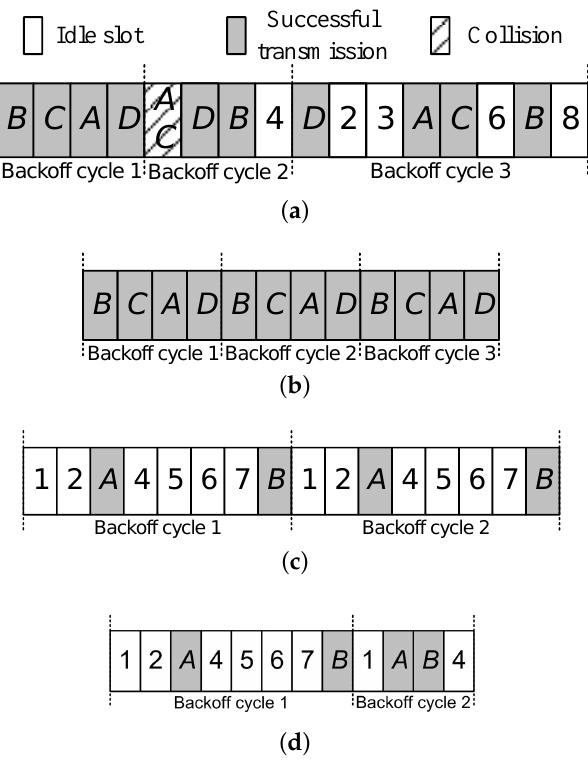
Figure 4. Channel accessing under different vehicle density. ( a ) Carrier Sense Multiple Access (CSMA)-based protocol under large vehicle density; ( b ) Our design under large vehicle density; ( c ) TDMA-based protocol under small vehicle density. ( d ) Our design under small vehicle